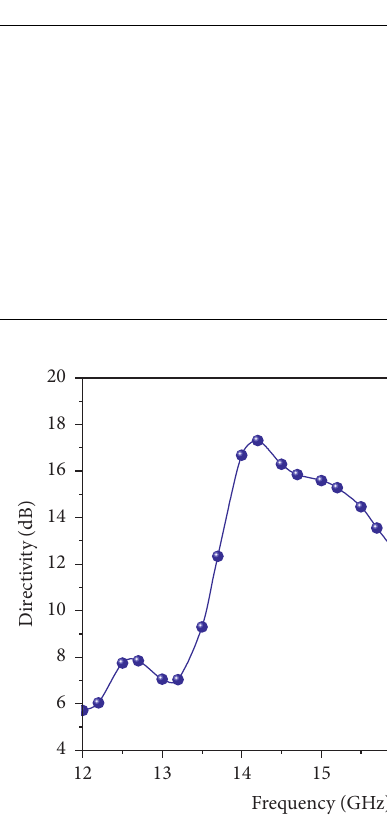
Figure 5: Simulated result of directivity for the proposed antenna based on single-layer metasurface. Table 2: Comparison of the proposed antenna with those reported in